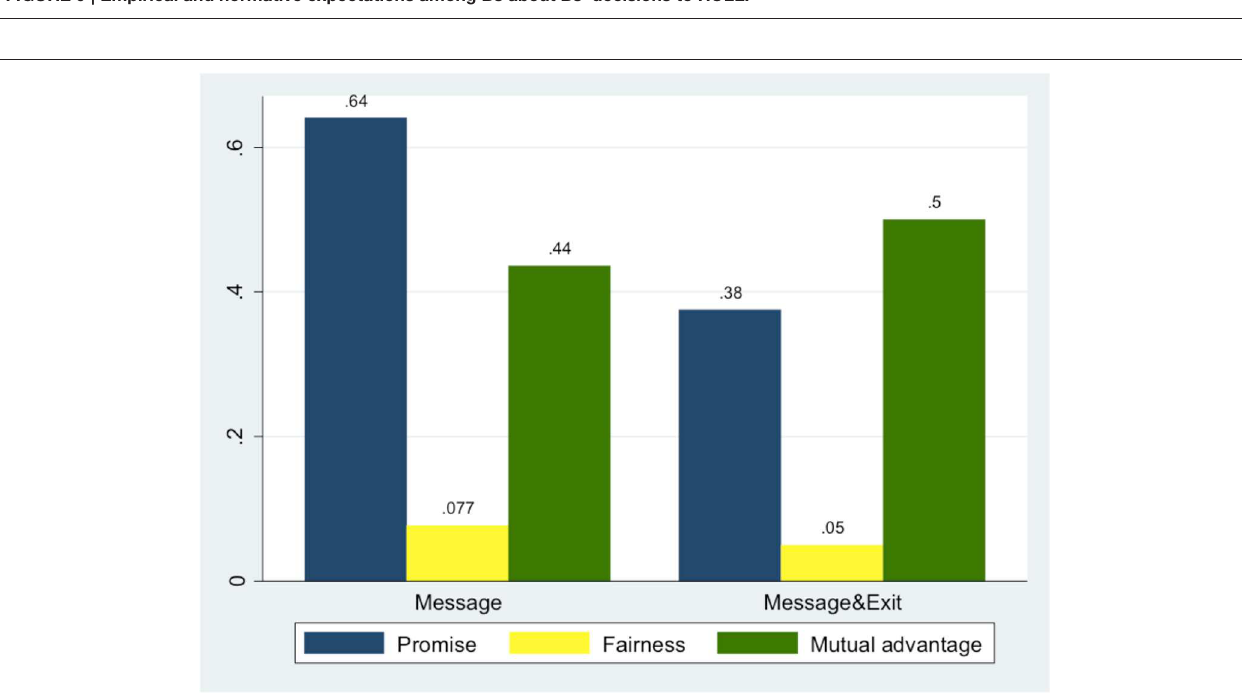
FIGURE 9 | Empirical and normative expectations among Bs about Bs’ decisions to ROLL.